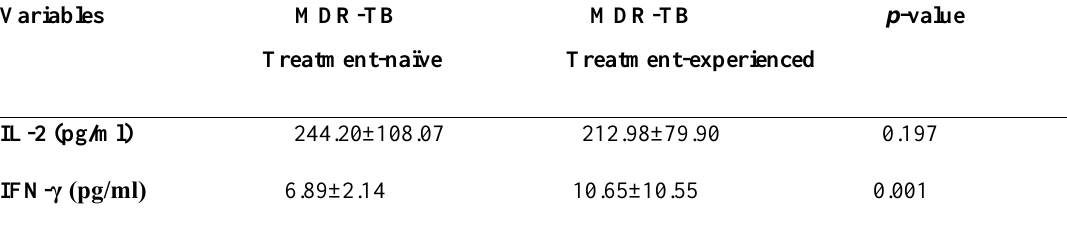
Table 5. Effect of anti-TB therapy on IL-2 and IL-10.